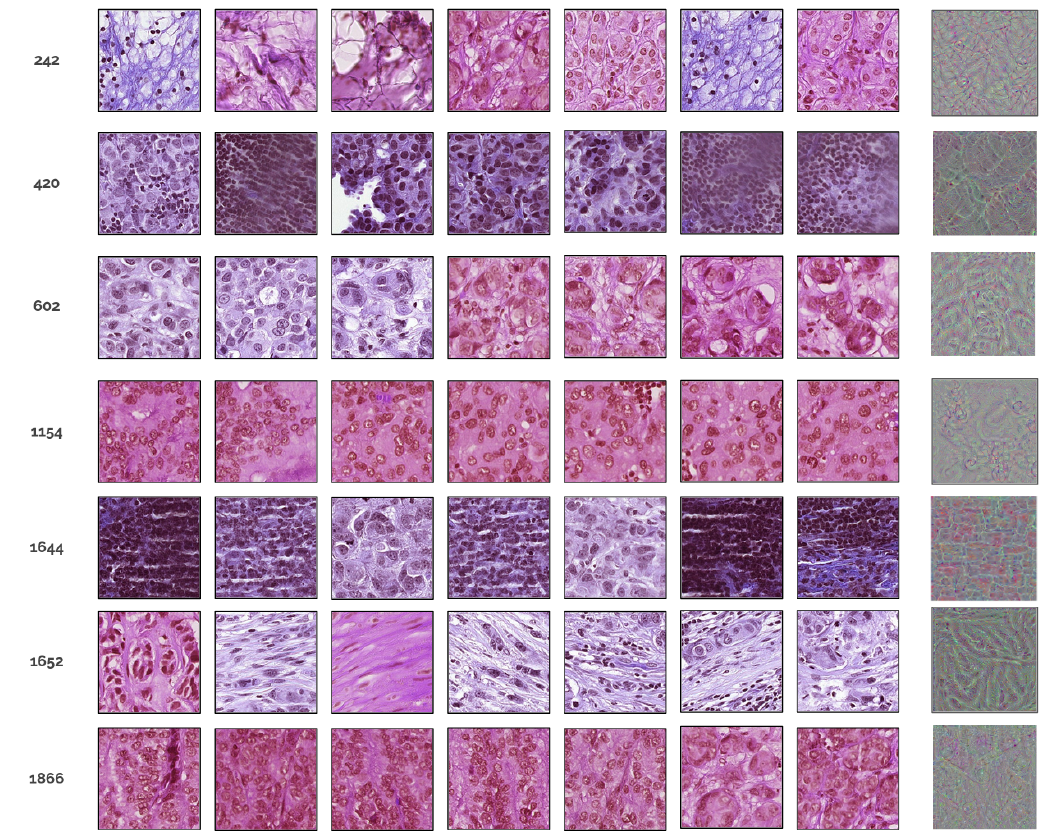
Figure A2. Features selected by CHOWDER model to describe “tumor”